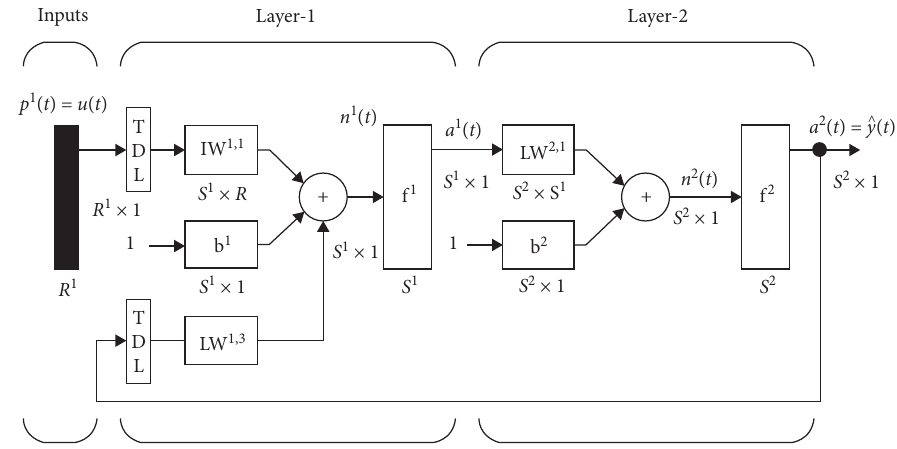
Figure 23: General diagram of the NARX model